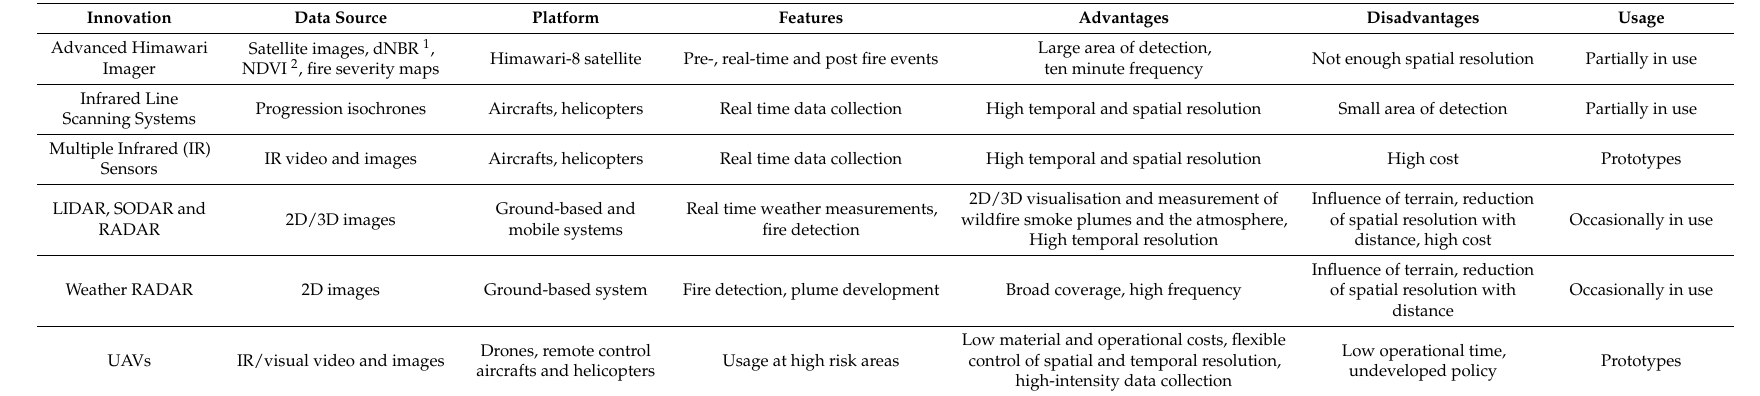
Table 3. List of innovations in wildfire data collection with immediate